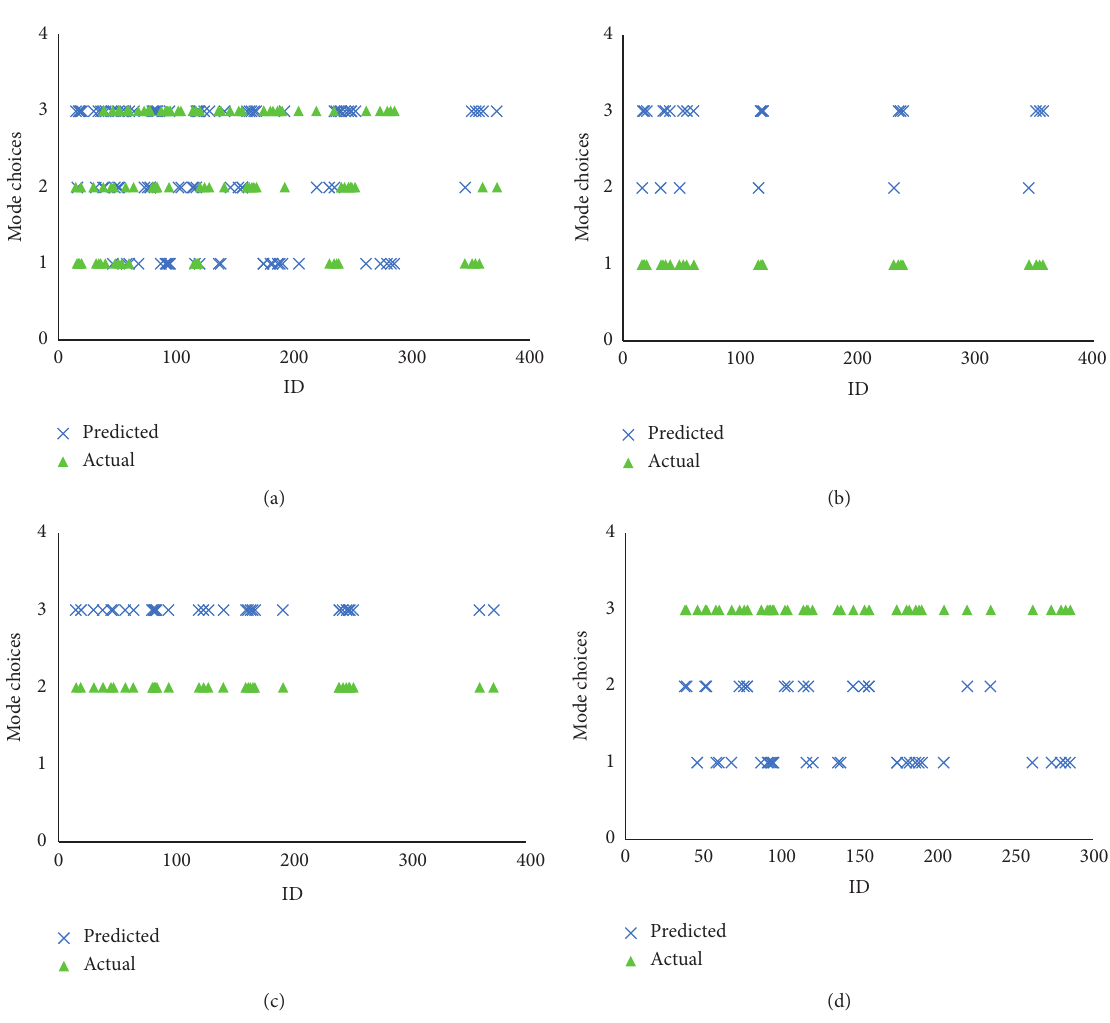
Figure 3: Misestimation of each mode. (a) Whole. (b) Car. (c) Bus. (d) Metro. Table 5: Misestimation of each mode. Table 6: Effect of high parking cost on mode choice